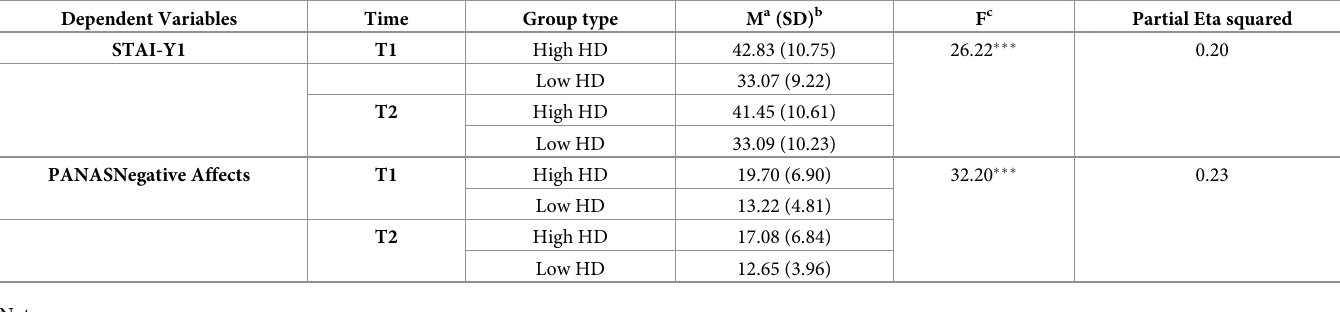
As expected, H-HD individuals had more frequent thoughts about their objects during the week as compared with the other group (H-HD: M = 12.25, DS = 6.61; L-HD: M = 6.96, DS = 5.19; F = 27.33, p-value < .001) (Fig 2). The H-HD group referred to a total of 654 beliefs related to the object (62.23%), against 397 of the L-HD (37.8%). Moreover, each day, the H-HD group reported a greater frequency of negative emotions (F = 35.72, p-value < .001) and higher levels of distress than the L-HD group (F = 46.59, p-value < .001) (Figs 3 and 4). Table 3. Repeated measures MANOVAs–tests of between-subjects